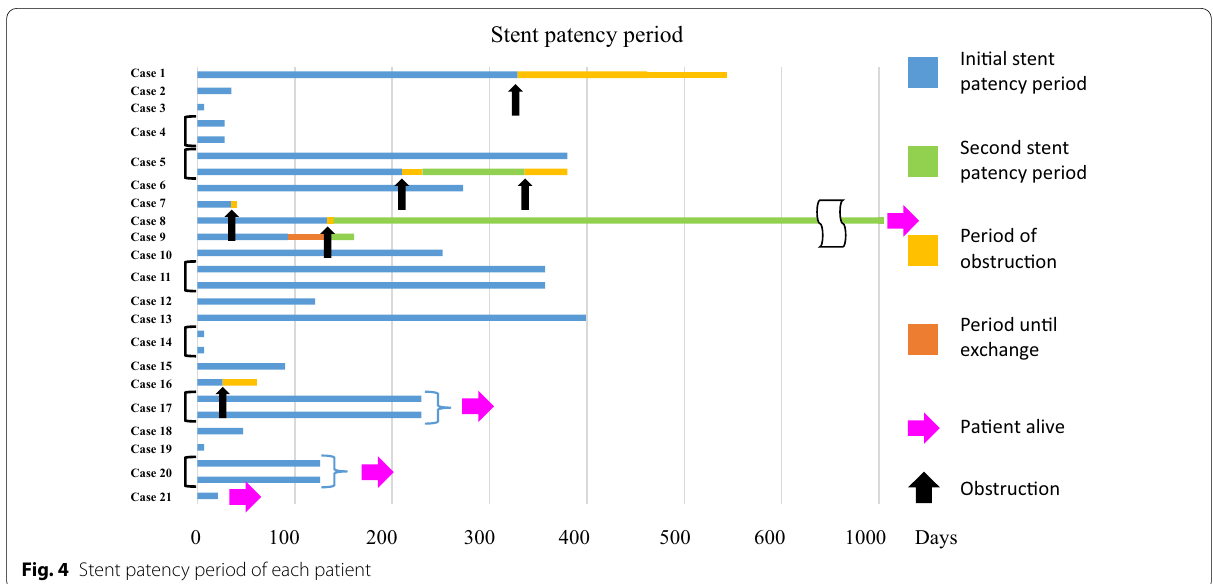
Fig. 4 Stent patency period of each